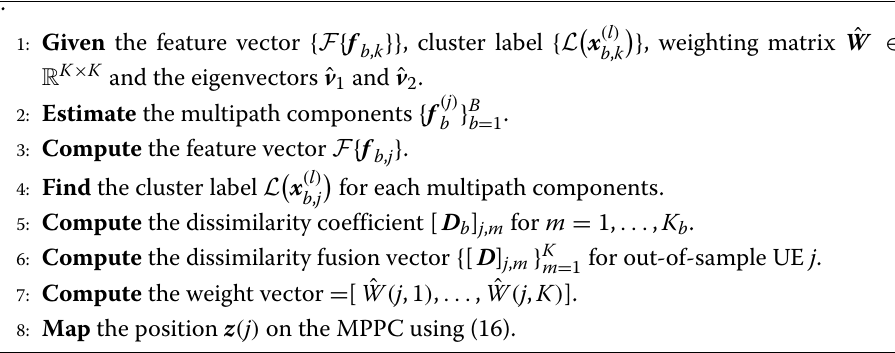
the Eigenvectors ˆ v 1 and ˆ v 2 are computed based on the normalized weighting matrix of the original data set.